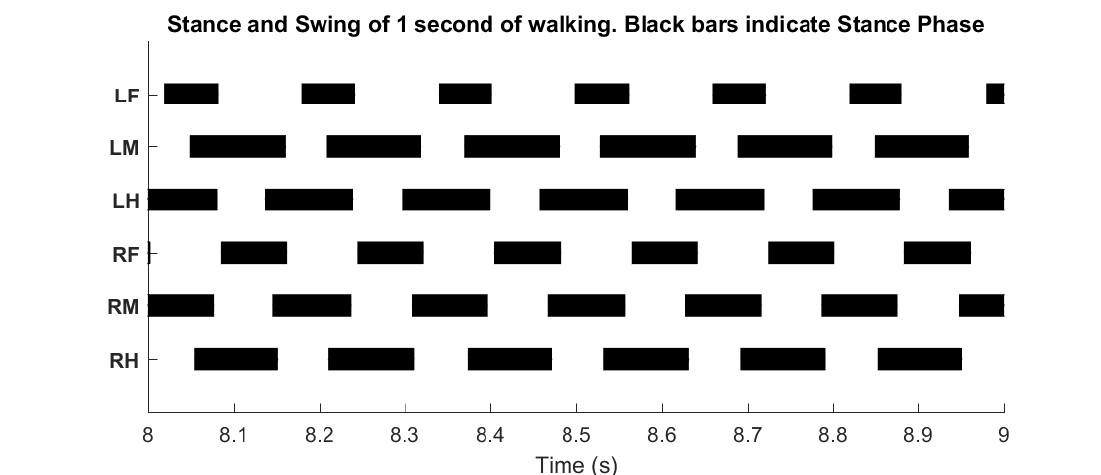
Figure 15. Inter-leg influences result in a stable tripod gait. Data presented over one second of walking. Black bars indicate stance